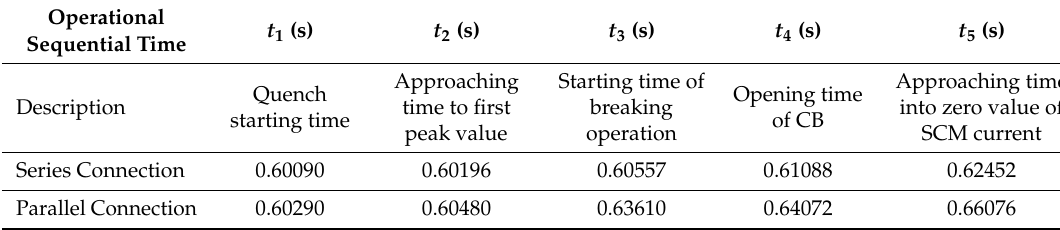
Table A2. Operational sequential time due to the winding method of the SFCLB using flux coupling with a tap